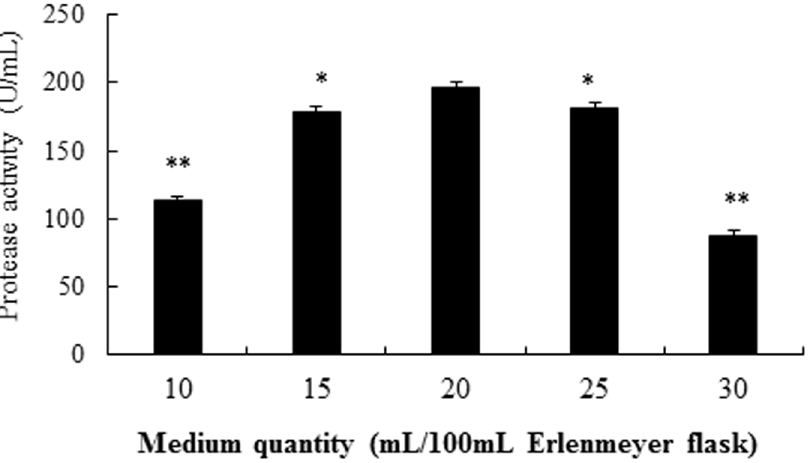
Fig 8. Effects of medium quantity in influencing the production of alkaline protease from strain SD8. The single factor investigated was selected at optimal conditions. * P < 0.05 and ** P < 0.01 compared to 20 mL/100 mL Erlenmeyer flask. All the data were given as means ± SEM (n =